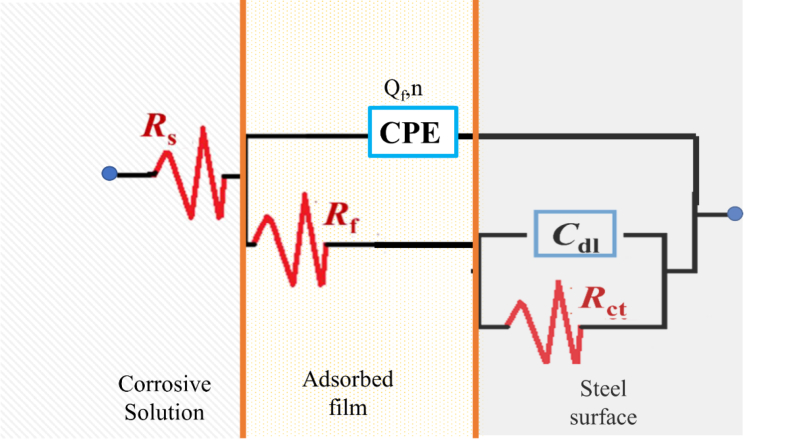
Model of the equivalent circuit.